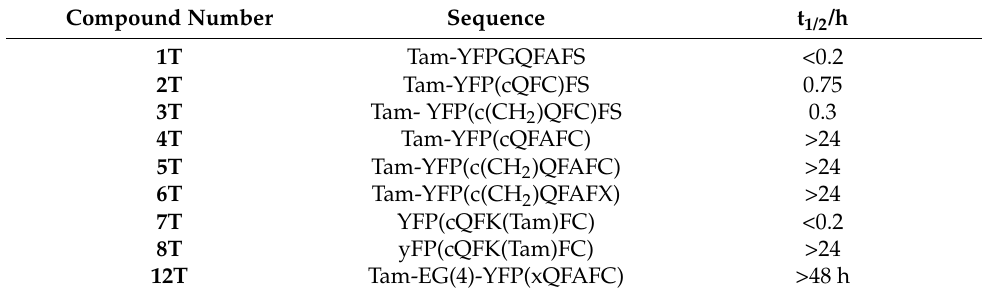
Table 2. Plasma stability of Tam-modified chemerin-9 derivatives determined in at least two inde- pendent experiments. Half-life t 1/2 was determined in GraphPad Prism with one-phase decay. Sites of cyclization are indicated by square brackets. Substitution of disulfides by methylene thioacetals is marked by a methylene group in the sequence. x = D-homocysteine.